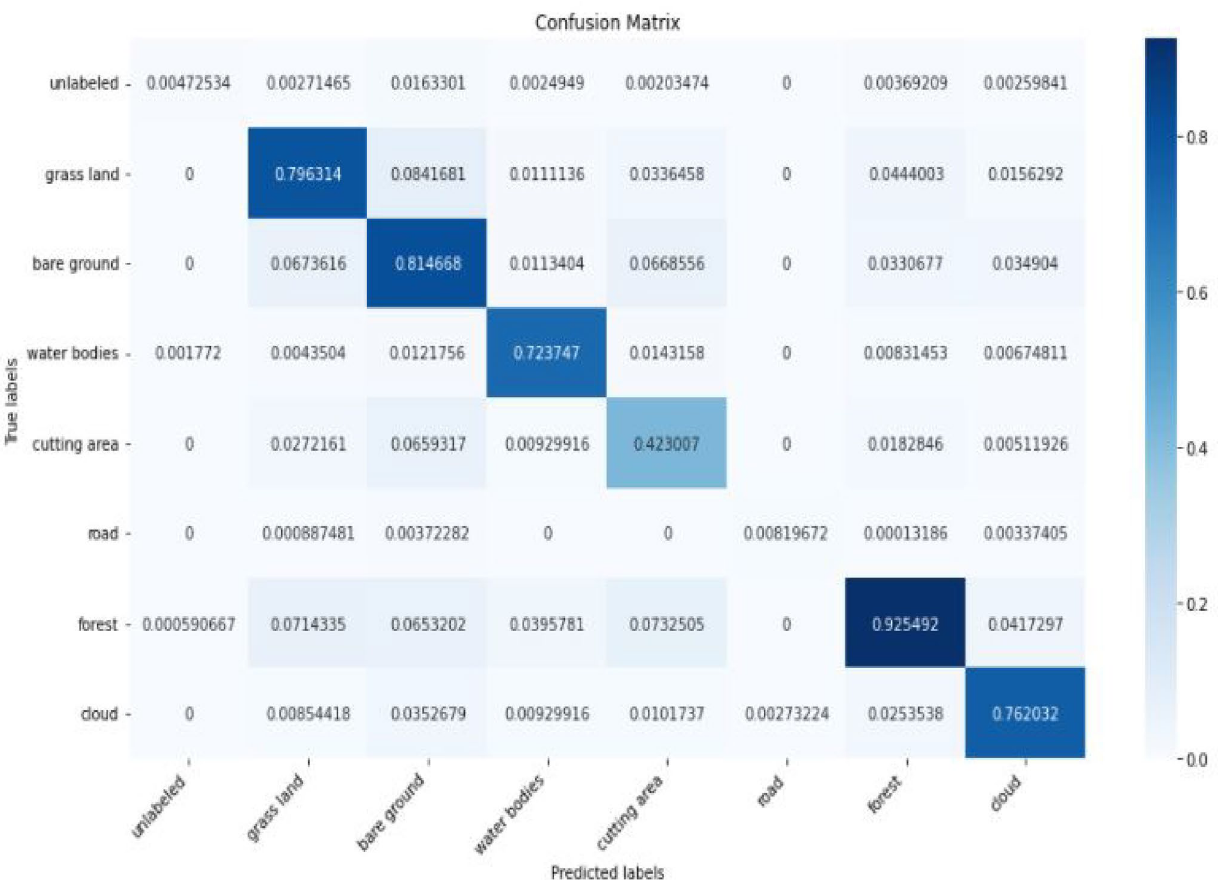
Fig. 4 Confusion matrix for CNN-RF